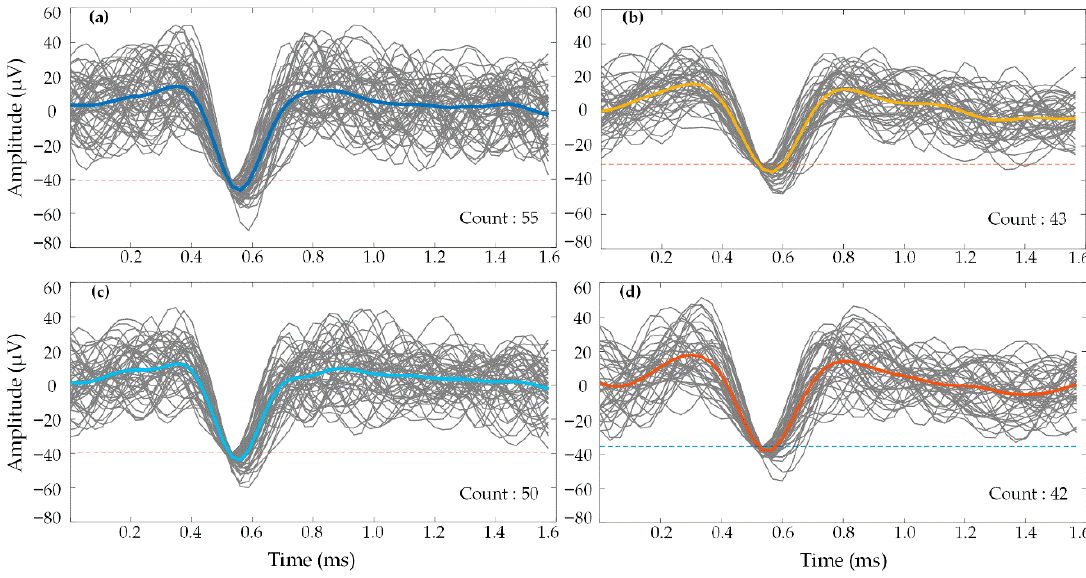
Figure 14. Waveforms of threshold crossing events recorded from the rapidly multiplexed chip (left column) and Cerebus (right column) extracted from the data shown in Figure 14. ( a , b ) show waveforms from one electrode, ( c , d ) are taken from a second electrode. Bold, colored traces represent the mean of each electrode’s threshold crossing waveforms. Dotted lines indicate the threshold.